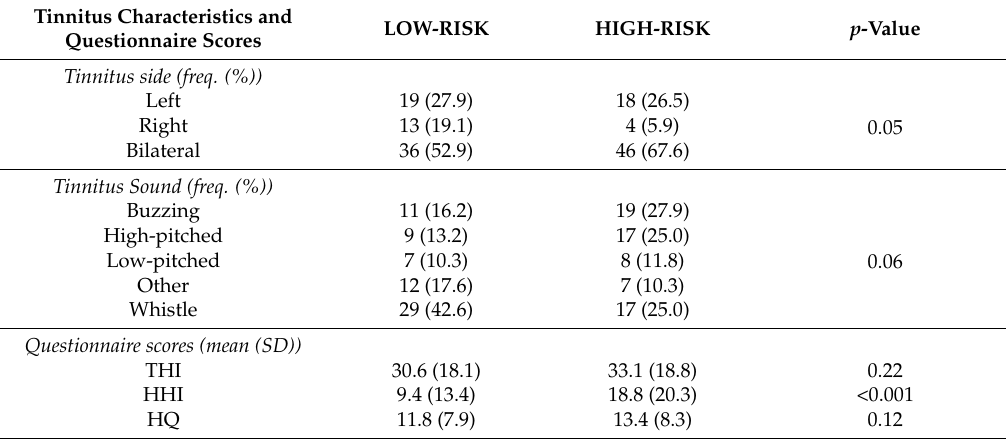
Table 3. Distribution of tinnitus characteristics and questionnaire scores in the LOW-RISK and HIGH-RISK groups. A significantly higher number of patients in the HIGH-RISK group had bilateral tinnitus, followed by unilateral tinnitus in the left ear. “Buzzing” and “high-pitched” tinnitus sounds were more common among HIGH-RISK individuals; “whistle” was more common among individuals in the LOW-RISK group. Patients in the HIGH-RISK group scored significantly worse for the Hearing Handicap Inventory (HHI) questionnaire compared to individuals in the LOW-RISK group; no significant differences were seen for the Tinnitus Handicap Inventory (THI) and the Hyperacusis Questionnaire